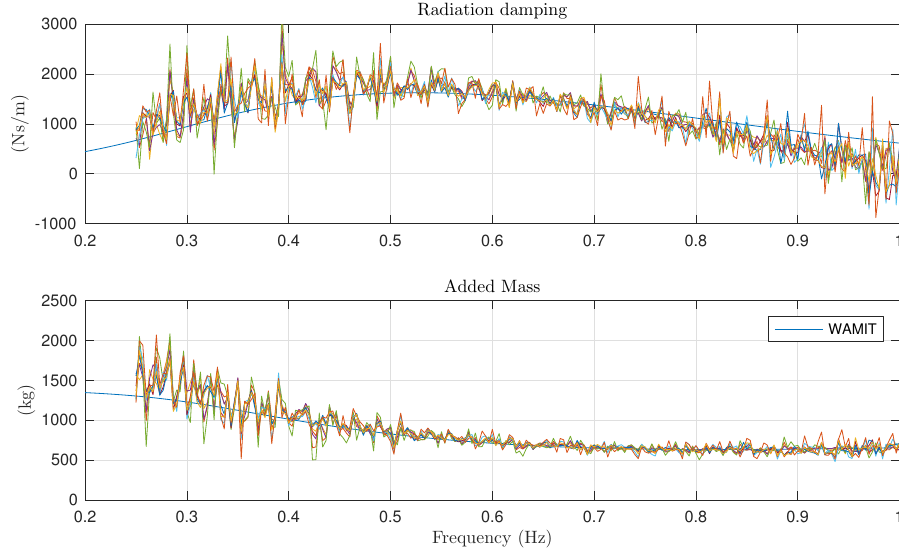
Figure 17. Comparison of radiation damping and added mass provided by WAMIT and calculated from all the forced oscillation experiments